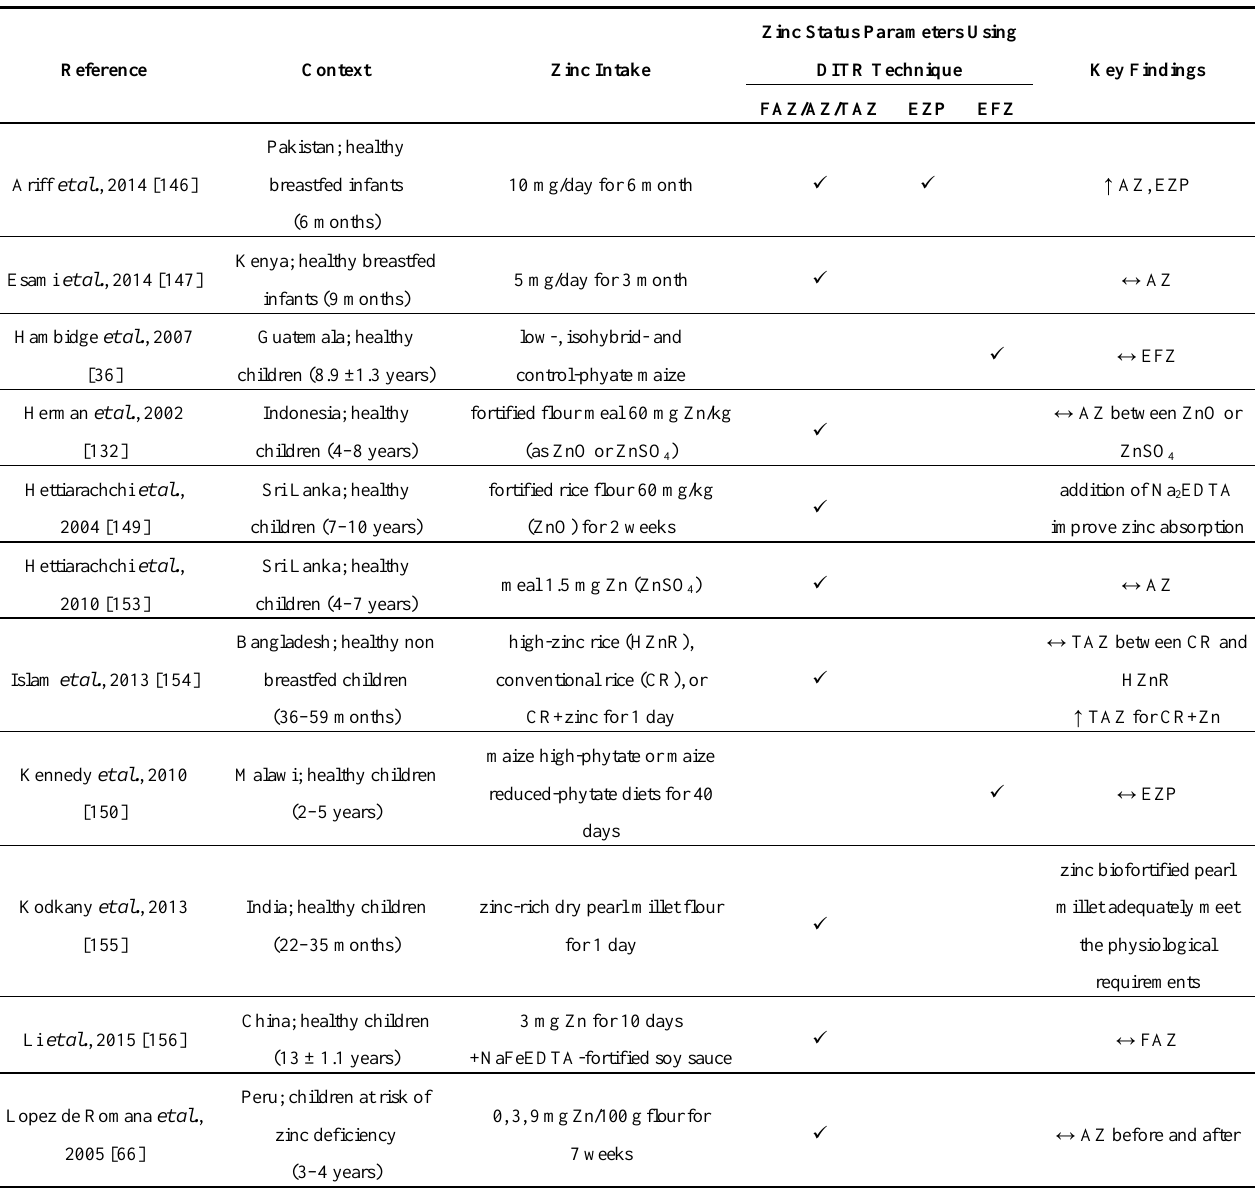
Table 1. Summary of studies that utilise the zinc stable dual isotope tracer ratio (DITR) technique to assess fractional absorption of zinc (FAZ), absorbed zinc (AZ), total absorbed zinc (TAZ), endogenous faecal zinc (EFZ) and exchangeable zinc pools (EZP) in children in low-income